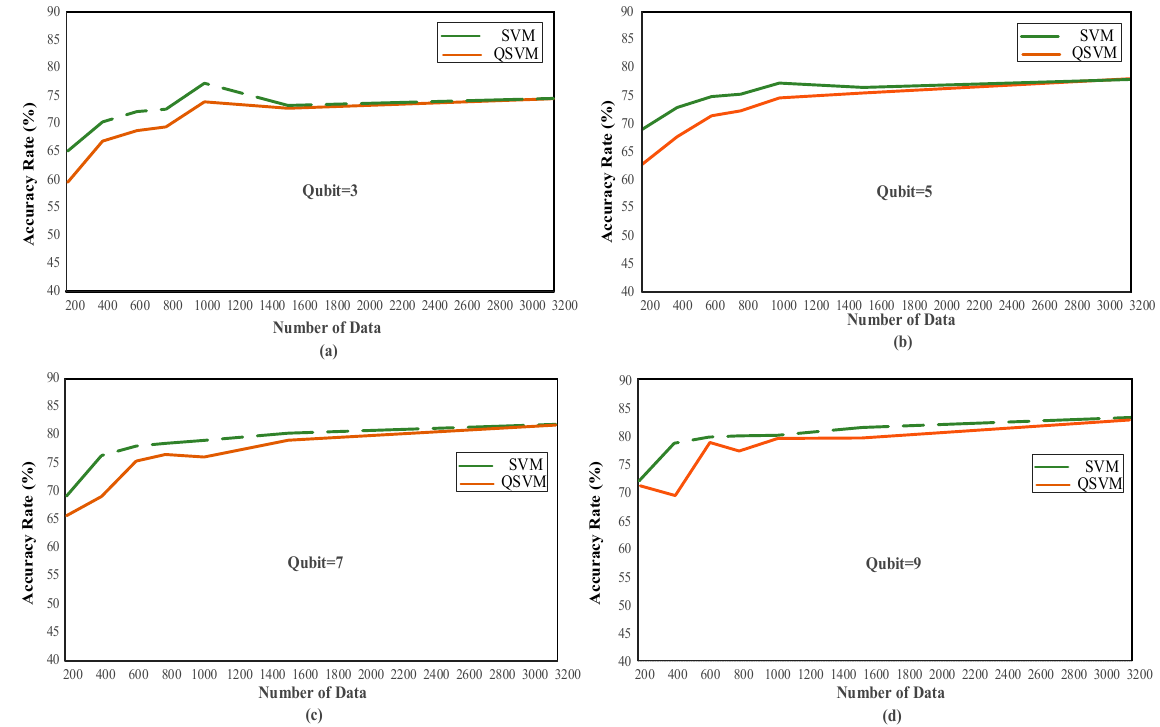
Figure 4. ( a ) The performance of data cases according to 3 qubits. ( b ) The performance of data cases according to 5 qubits. ( c ) The performance of data cases according to 7 qubits. ( d ) The performance of data cases according to 9 qubits. Table 2. Accuracy rates with mean and standard deviations for QSVM and SVM